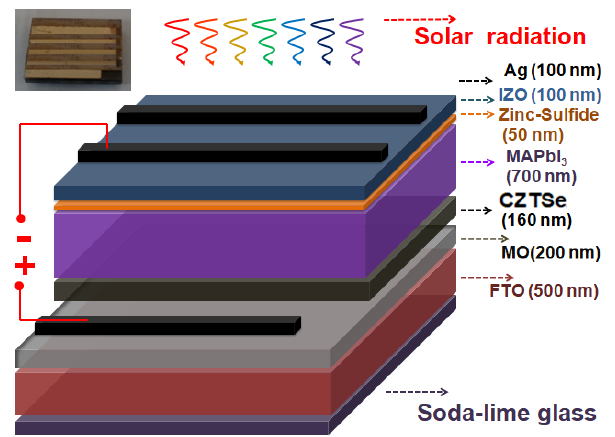
Figure 1. The complete scheme of nanostructured MAPbI 3 perovskite solar cell with Cu 2 ZnSnSe 4 HTM layer.